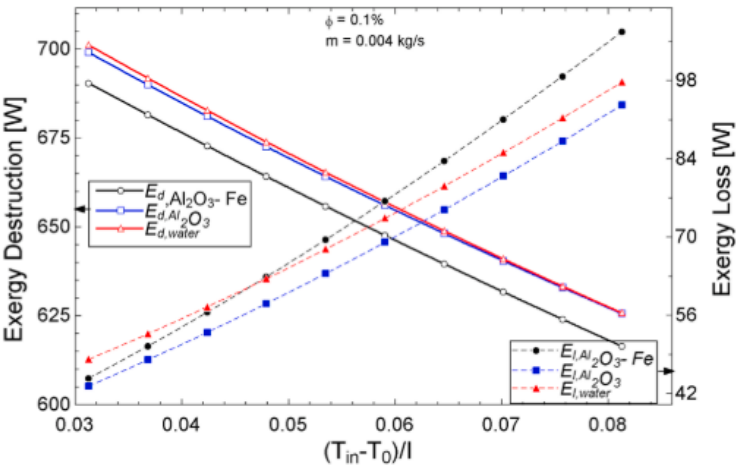
Figure 13. Exergy destruction and exergy loss performance of Al 2 O 3 ‐ Fe and Al 2 O 3 nanofluid and water against increasing temperature parameters for a flat plate collector application (Adapted from Okonkwo et al. [112]).